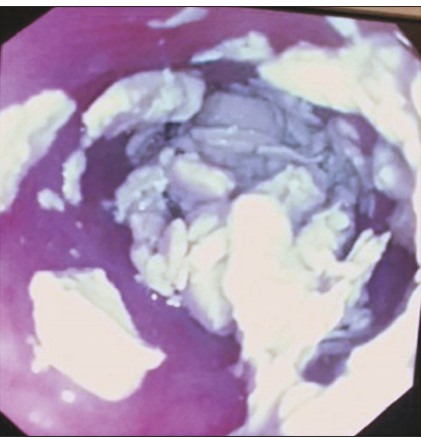
Figure 1: Endoscopic view of the upper gastrointestinal tract, revealing the presence of calcified debris, within the esophagus, secondary to nasogastric tube